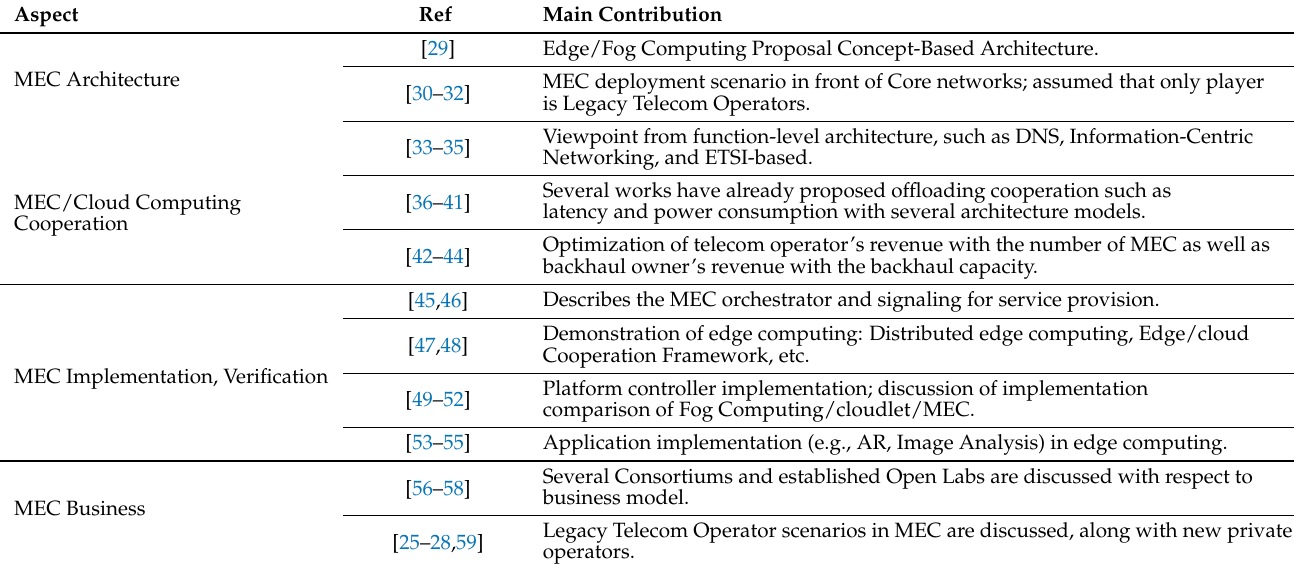
Table 1. Comparison of Related Technical Works from Several